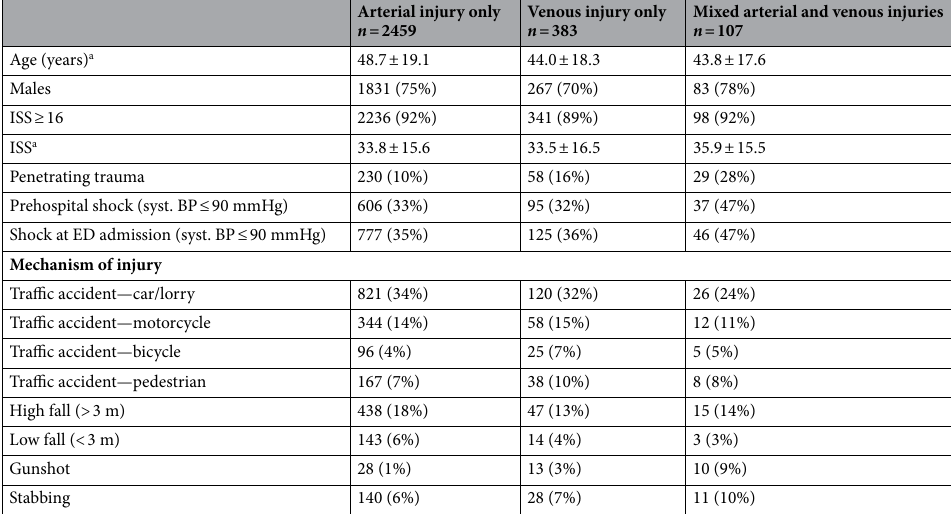
Table 1. Basic characteristics of 2949 patients with abdominal vascular injuries. ISS Injury Severity Score. a Mean with standard deviation.